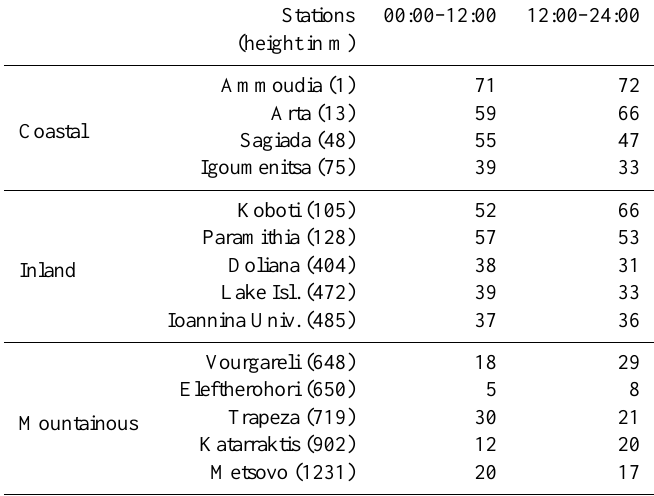
Table 5. The percentage of convective part of precipitation obtained by the use of Kain-Fritsch-2 for the two 12-h intervals ( t + 12, t + 24).